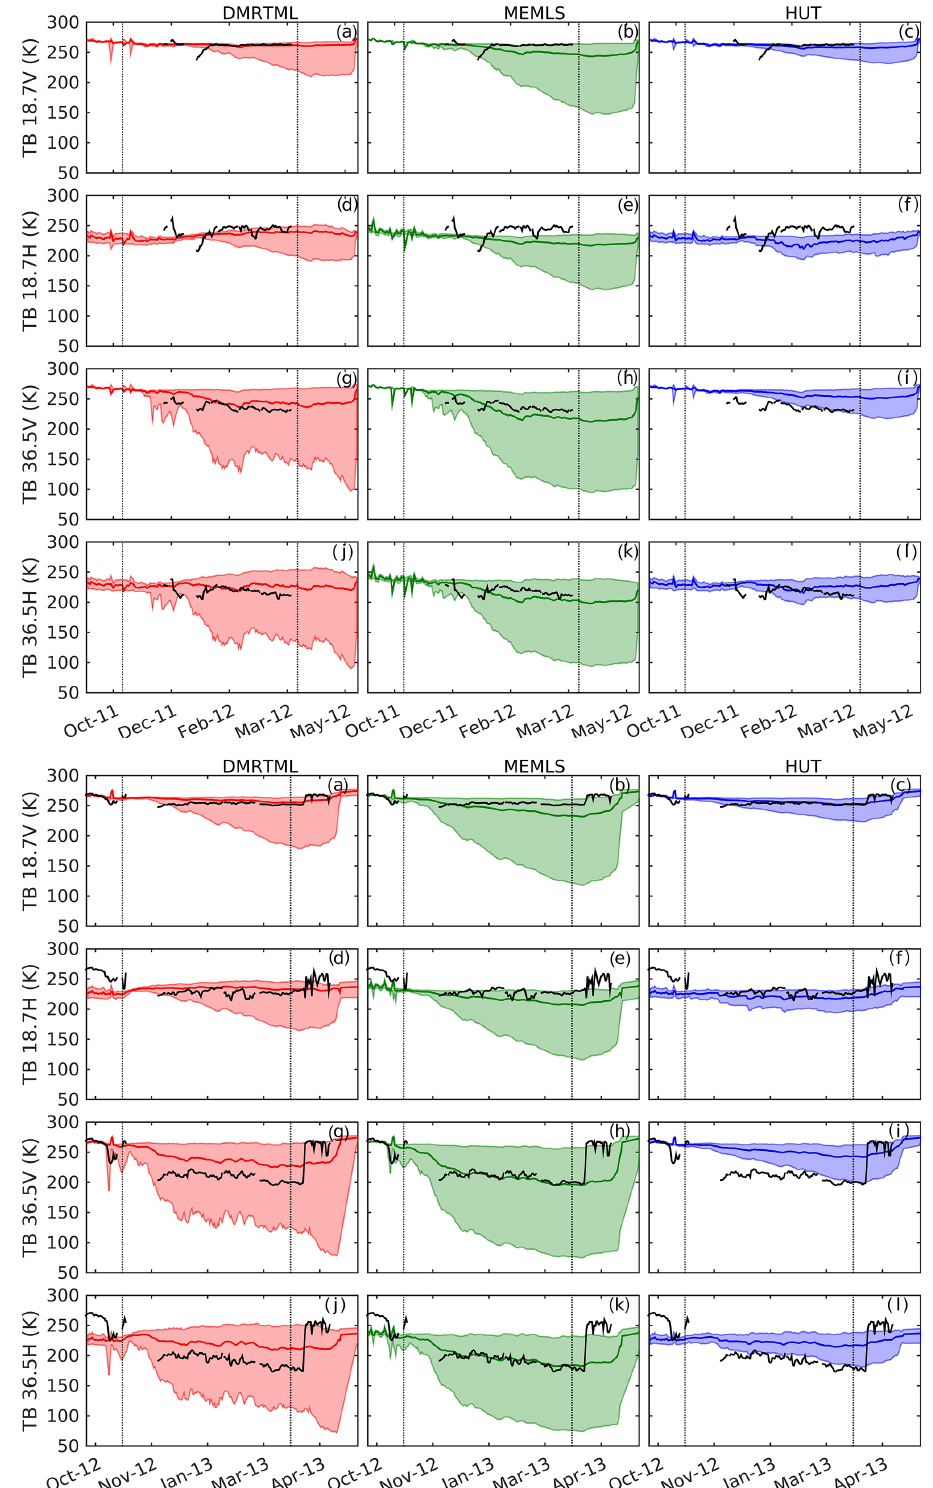
Figure 5. Range and mean of brightness temperature over the two winter seasons as simulated with the DMRT-ML, MEMLS, and HUT models, driven by 63 JIM outputs and 3 microstructure evolution models. Black lines indicate the observed brightness temperatures. Vertical dashed lines enclose the period of analysis (1 November–31